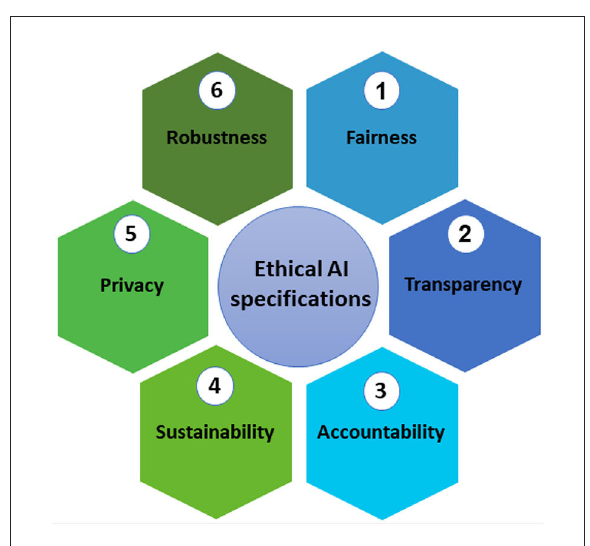
FIGURE3 Ethical artificial intelligence principal in digital